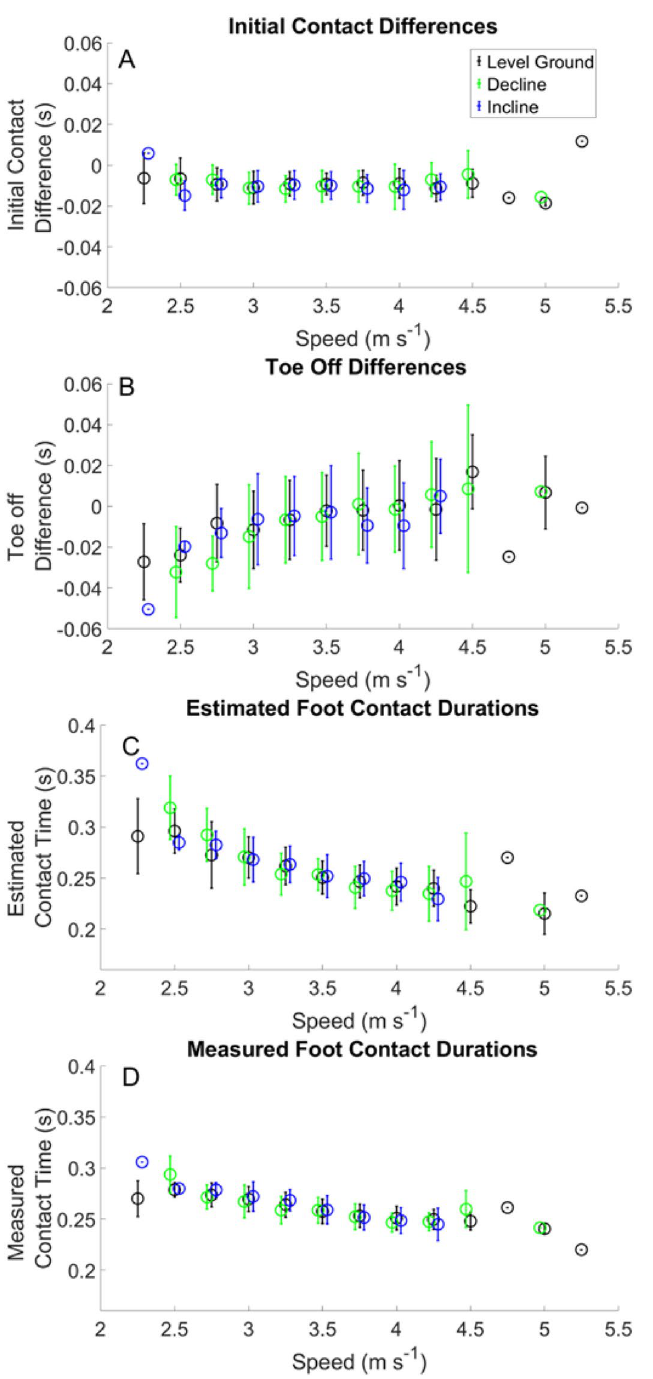
Figure 1. Gait event differences estimated from foot mounted IMUs (Panels A and B ). Panels ( C ) and ( D ) show the estimated and measured contact